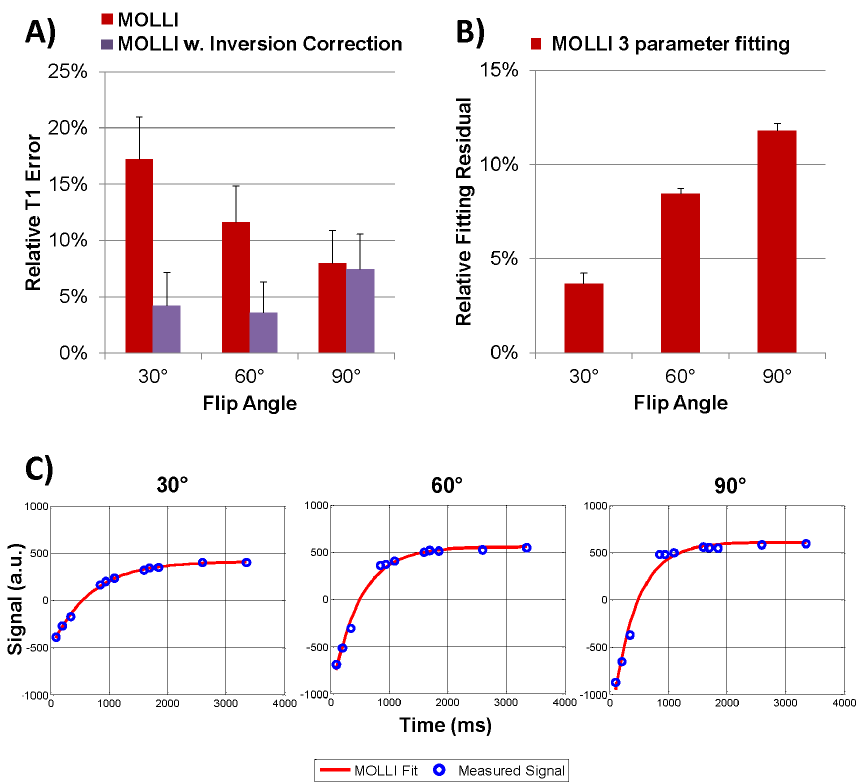
Figure 2. MOLLI results in the calf muscle (n=6): A) T 1 errors obtained at 30 6 , 60 6 and 90 6 readout flip angle for conventional MOLLI fitting (Eq.1) and MOLLI fitting with inversion correction (Eq.2); B) Relative fitting residuals for the three parameter fit used in Eqs.1 and 2. Note the increasing residuals with the three parameter fitting (used by Eqs.1 and 2) at higher flip angles; C) Measured signal and curves fit with the 3-parameter MOLLI fit in the calf muscle of one volunteer at 30 u , 60 u and 90 u . Notice the increasing discrepancy between the fit and measured data at higher flip angle, confirmed by the increase in fitting residual in (B).